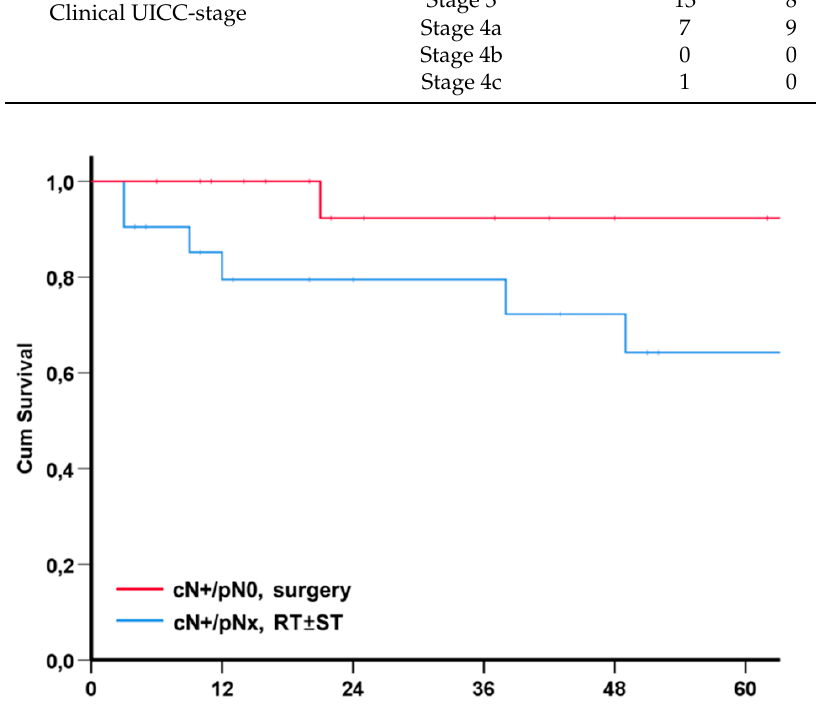
Table 4. Head and neck functional integrity scale outcome of surgically treated patients with treat- ment de-escalation (cases) and patients with primary RT ± ST (controls).